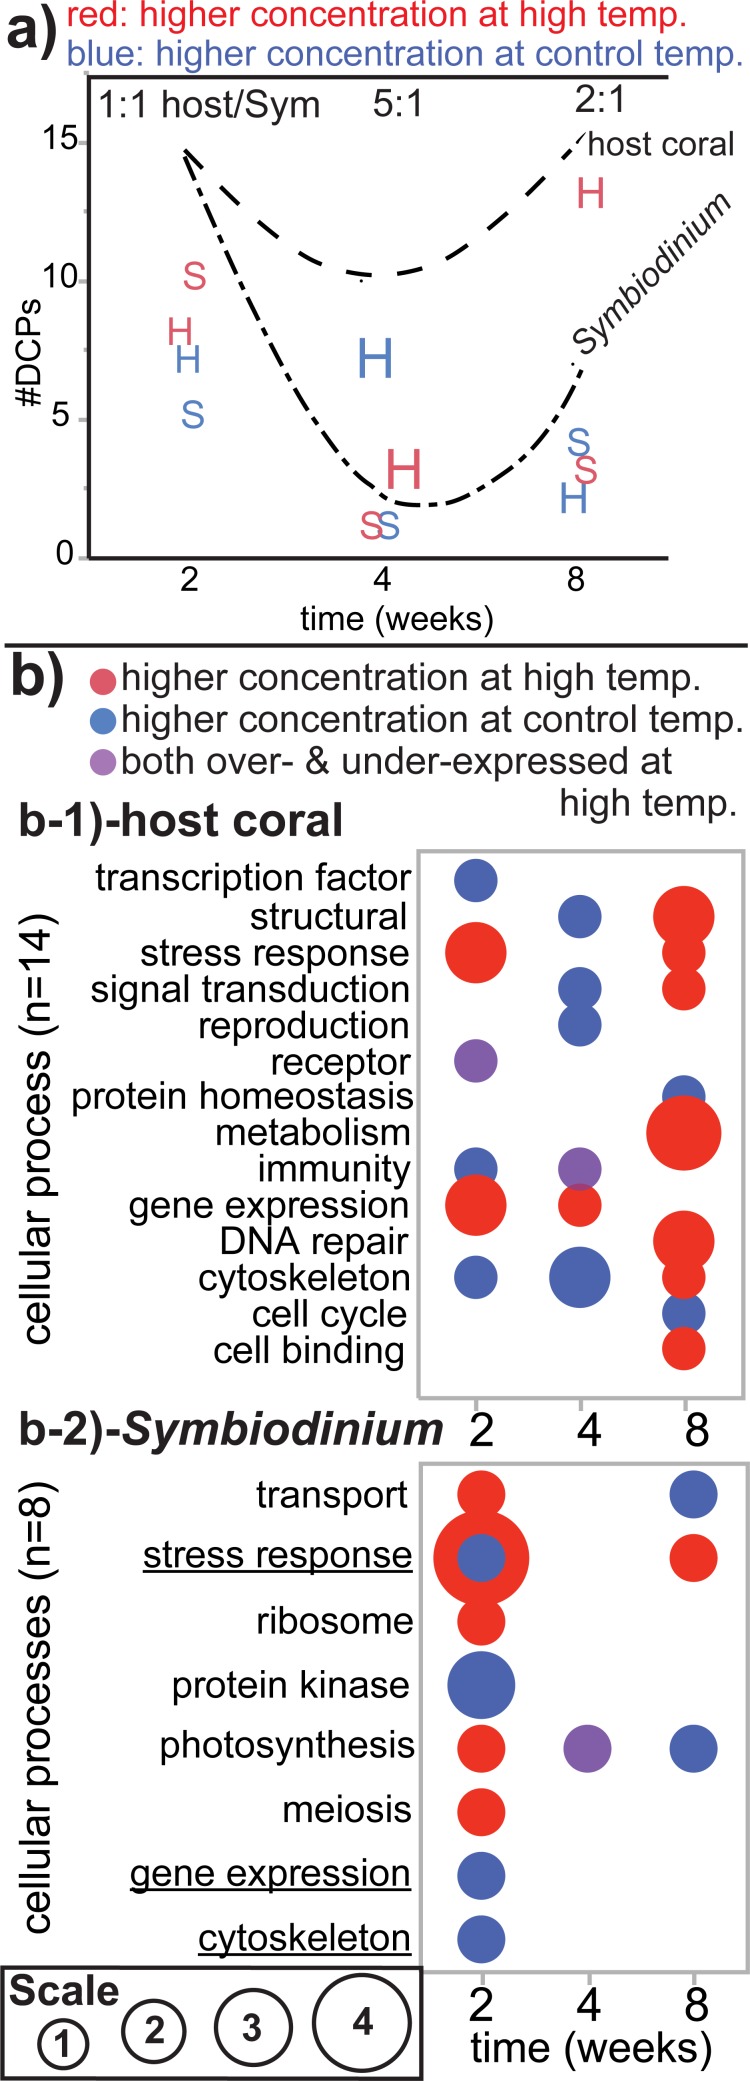
Summary of the dataset.The number of differentially concentrated proteins (DCPs) was plotted over time for both the host coral (“H”) and Symbiodinium (“S;” Sym) for proteins documented at higher concentrations at high temperature (red icons) and those over-expressed at the control temperature (blue icons). The sizes of the icons are proportional to the host/Sym DCP ratio at each sampling time (listed at the top of the plot). The upper and lower hatched lines represent the total number of DCPs at each sampling time for the host coral and Sym, respectively. In (b) the sizes of the bubbles are proportional to the number of DCPs involved in each cellular process for both the host coral (b-1) and Sym (b-2). Purple bubbles represent those cellular processes for which one protein was over-expressed at high temperature, whereas another was documented at higher concentrations at the control temperature. This annotation is not used for the Sym “stress response” category at the two-week sampling time (b-2), in which 1 and 4 DCPs were more highly concentrated by the control and high-temperature samples, respectively. Underlined functional categories in b-2 reflect processes that were also temperature-sensitive in the host coral compartment (b-1).